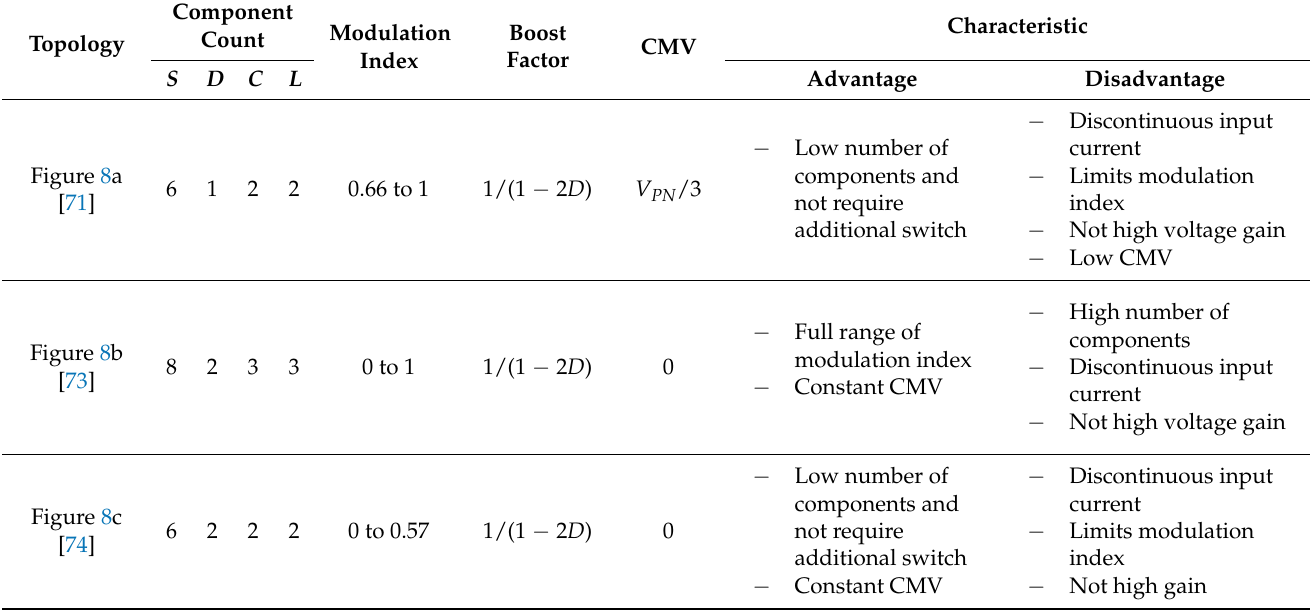
Table 3. Comparison of different CMV reduction impedance-source-networks-based topologies.